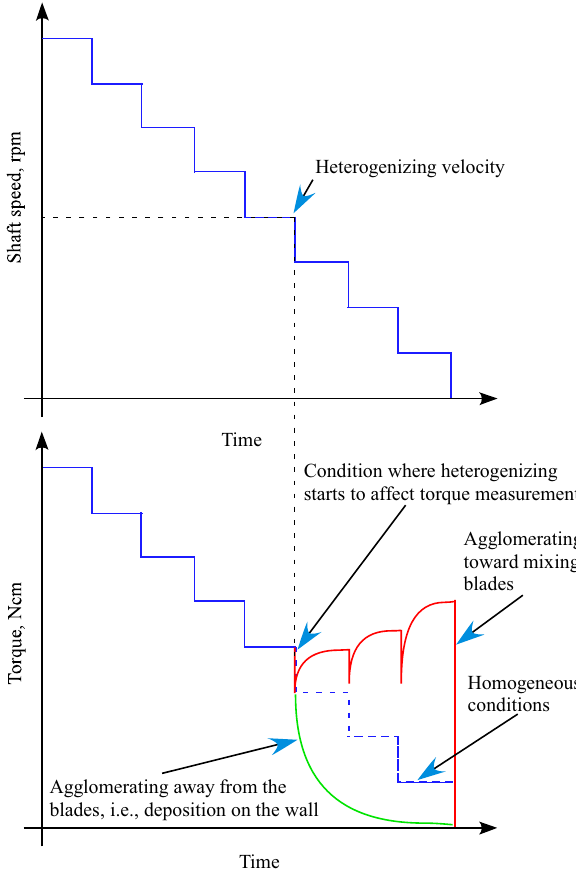
Fig. 7 Hypothetical torque response during shaft speed ramp